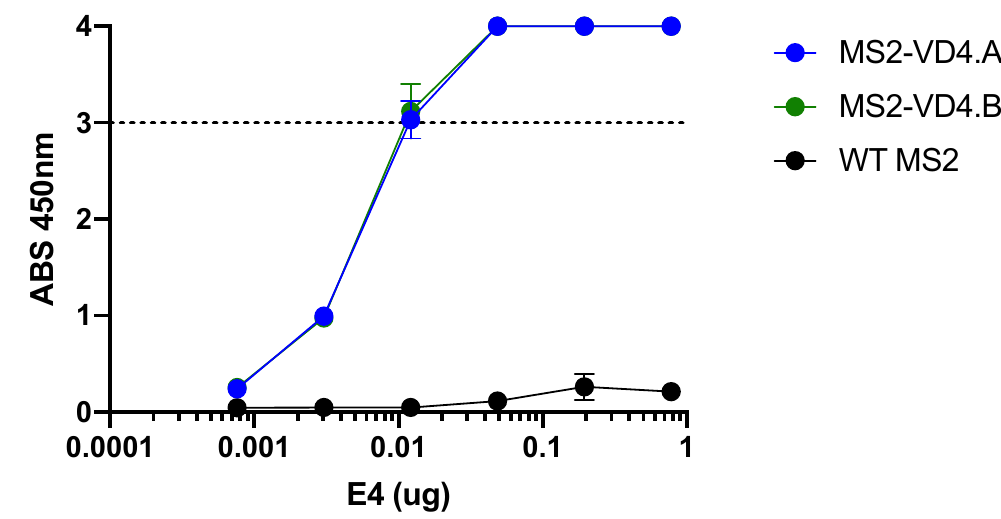
Figure 5. E4 mAb binds to MS2 VLPs displaying the VD4 epitope. E4 mAb binding capacity to MS2-VD4.A and MS2-VD4.B as measured by ELISA, demonstrating binding above that of WT MS2 across a range of dilutions. Quantitative data represent the mean ± SD.